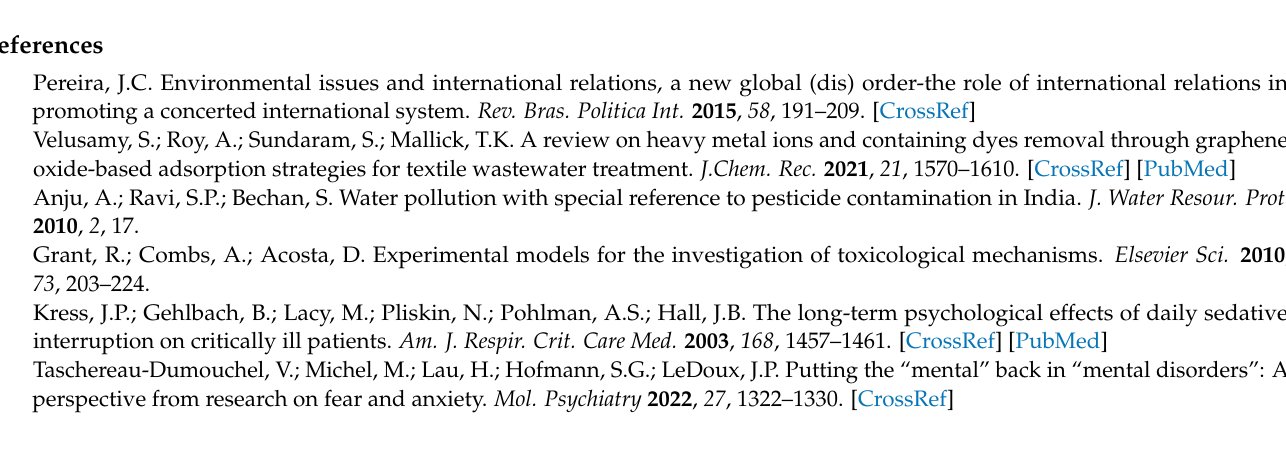
Figure S2: (A) Effect of various supporting electrolytes on the anodic peak current of IBP using electrolytes; Figure S3: (A) Effect of deposition potential on the peak current of 0.09 mM ibuprofen potential; Figure S4: (A) Effect of deposition time on the peak current of 0.09 mM ibuprofen using MWNTs/Ag-ZnO/GCE. (B) Plot between Ip vs. accumulation time; Table S3: The values of current for total drug ( I TD ) free drug ( I FD ) and the difference of the two currents ∆ I ; Table S4: Data employed for the determination of function Φ and for the construction of plot Φ versus log [FD] in the case of the IBP-BSA complex in Figure